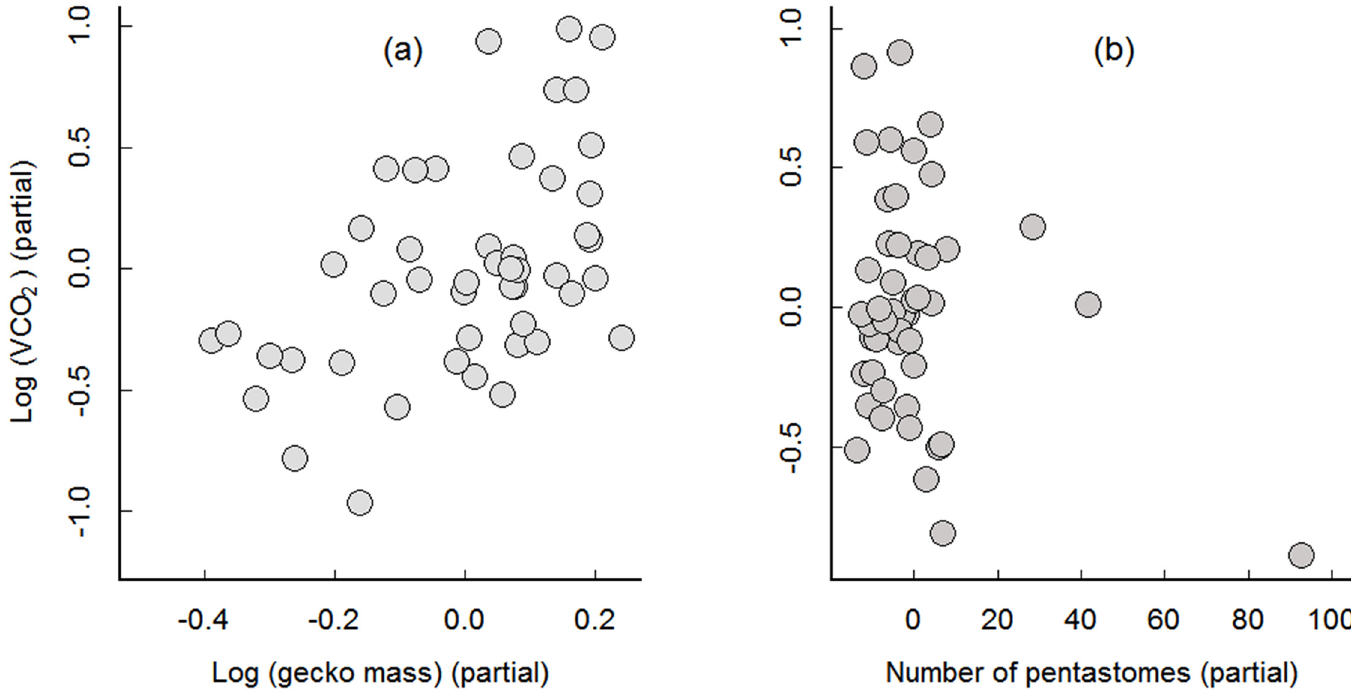
Fig 1. Relationship between mass and number of pentastomes versus log (VCO 2 ) production for rested geckos. Partial regression plots ( y axis: residuals of regressing the response variable on the explanatory variables, but omitting the explanatory variable of interest, and x axis: residuals of each explanatory variable of interest regressed on all remaining explanatory variables) of (a) the relationship of log (gecko mass) to log (VCO 2 ), given the effect of number of pentastomes, ( n = 48); and (b) the relationship of number of pentastomes to log (VCO 2 ) given the effect of log (gecko mass). Minimal regression model for the rested gecko experiment: log (VCO 2 ) = (1.023 × log (gecko mass)) – (0.005 × number of pentastomes) – 2.465; model adjusted R 2 = 0.2093.